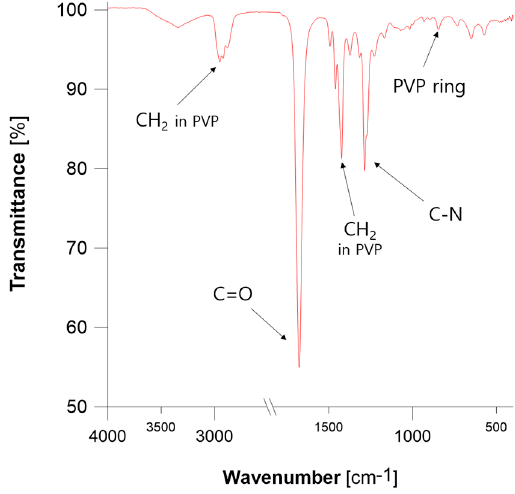
Figure 6. The ATR FT ‐ IR spectrum of PVP ‐ PtNPs.